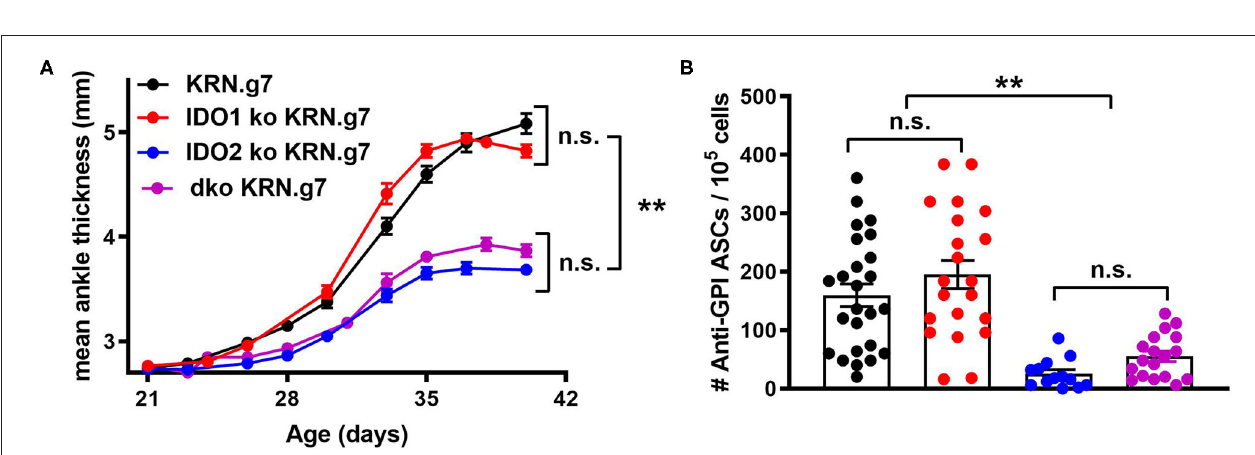
FIGURE 2 | Deletion of both IDO1 and IDO2 inhibits autoantibody production and alleviates arthritis, phenocopying IDO2 single knockout mice. (A) Rear ankles were measured as an indication of arthritis and represented as mean ankle thickness ± SEM from n = 14 wt, n = 10 IDO1 ko, n = 12 IDO2 ko, and n = 9 IDO1/IDO2 (dko) KRN.g7 mice. (B) The number of anti-GPI ASCs from the joint draining lymph node was determined using an ELISpot assay. Symbols represent individual mice and histograms show the mean number of ASC ± SEM from n = 25 wt, n = 21 IDO1 ko, n = 13 IDO2 ko, and n = 18 dko KRN.g7 mice, pooled from a minimum of 4 independent litters of each genotype. P -values were calculated by one way-ANOVA followed by comparison of means with Tukey’s post-hoc multiple comparison correction. ** p < 0.01, n.s., not